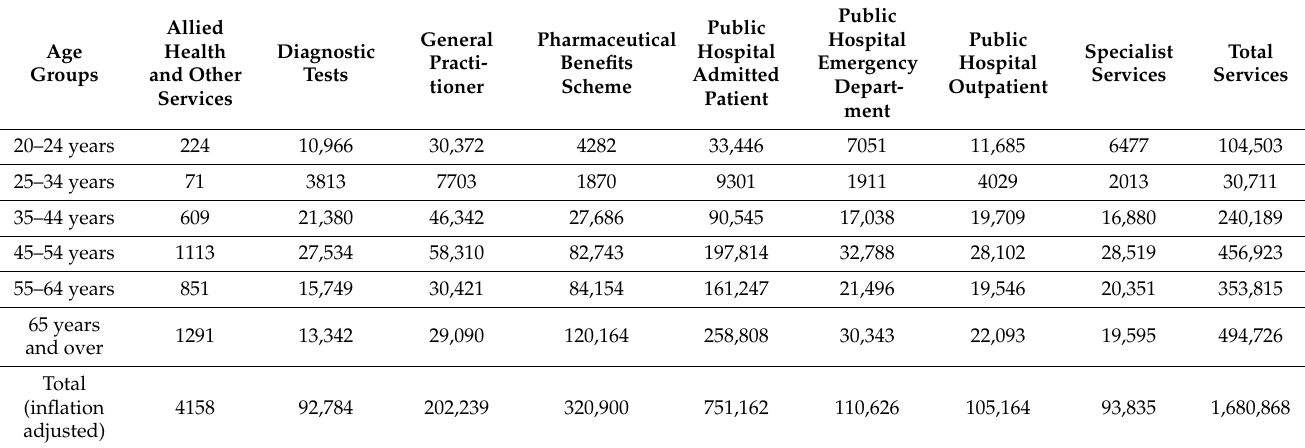
Table A1. Extra costs incurred due to LHL for people diagnosed with CVD in the Blacktown LGA (Domain 6).